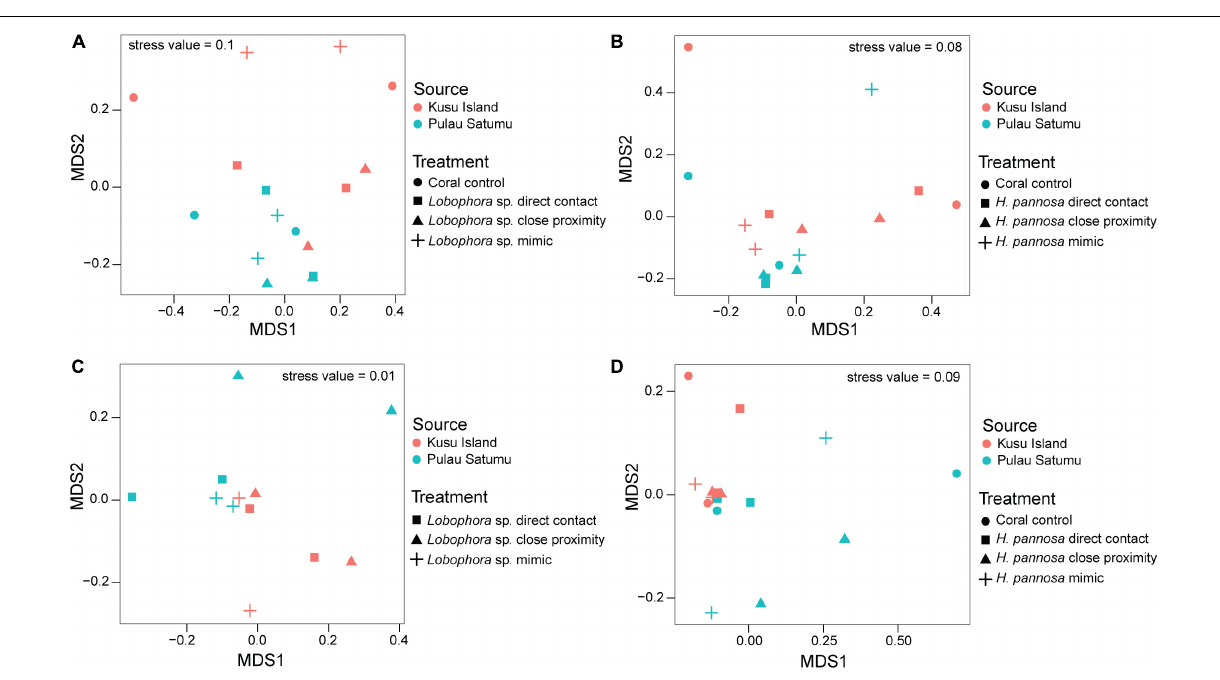
FIGURE 3 | nMDS plots of the prokaryotic community structure of Pocillopora acuta (A,B) and Merulina ampliata (C,D) coral fragments that had interactions with Lobophora sp. (left panels) and Hypnea pannosa (right panels). Color is used to indicate whether corals were collected from either Kusu Island (red) or Pulau Satumu (blue). Control samples were excluded in the nMDS plots for interactions between M. ampliata and Lobophora sp. (see Supplementary Figure 9 for nMDS plot with all